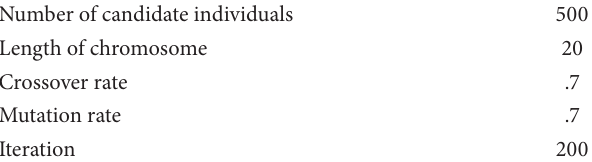
Table 8: GA parameter